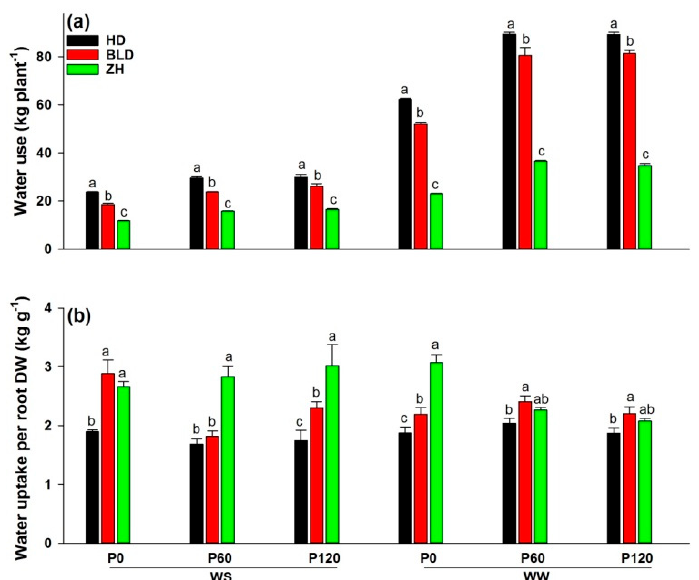
Figure 1. ( a ) Water use (kg plant − 1 ) and ( b ) water uptake per root DW (kg g − 1 ) at maturity of three soybean genotypes (Huandsedadou (HD), Bailudou (BLD), and Zhonghuang 30 (ZH)) exposed to three P concentrations (0 (P0), 60 (P60) and 120 (P120) mg P kg − 1 dry soil) under water-stressed (WS) and well-watered (WW) conditions. Means ( n = 3) with different letters in any one set of three genotypes differ significantly at p = 0.05.